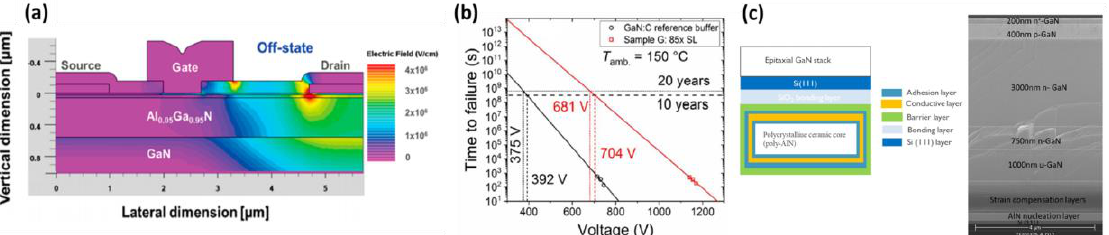
Figure 8. ( a ) A simulated electric field in a GaN high electron mobility transistor (HEMT) in off-state, with a drain bias of 300 V. ( b ) TTF (Weibull scale factor, 63.2% failure) dependence on the drain voltage along with lifetime extrapolations comparing the reference GaN:C and AlGaN/AlN superlattice buffer. ( c ) Schematic image of QST ® engineered substrates with poly-AlN core (with epitaxial GaN stack on top), and cross-sectional SEM image of a vertical device stack with a total GaN thickness of 5.4 µm on 200 mm engineered substrates [159–161]. Figure reproduced with permission from IEEE Transactions on Electron Devices and Elsevier Microelectronics Reliability.